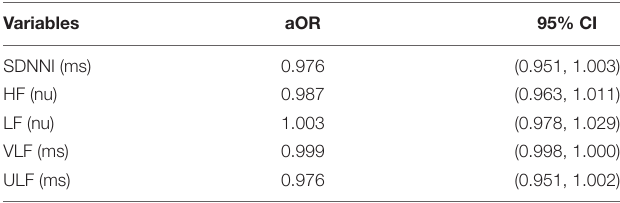
TABLE 7 | Spearman’s correlation coefficients between HRV parameters and the duration of POD.